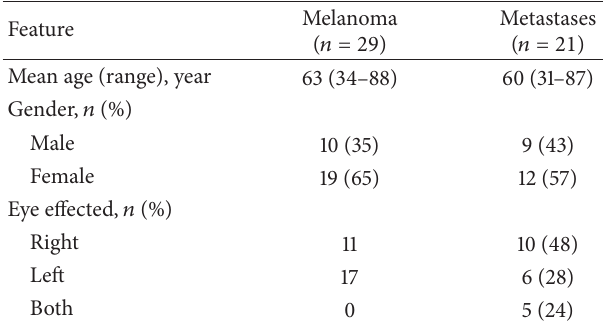
Table 1: Demographic features of 50 patients with choroidal tumors (50